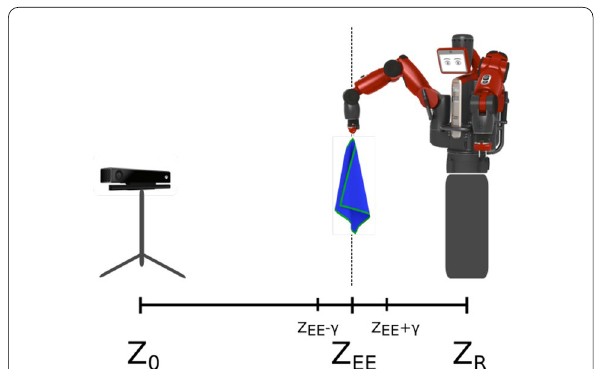
Fig. 8 The robot holds the cloth by one of the corners placing it between the camera and the robot